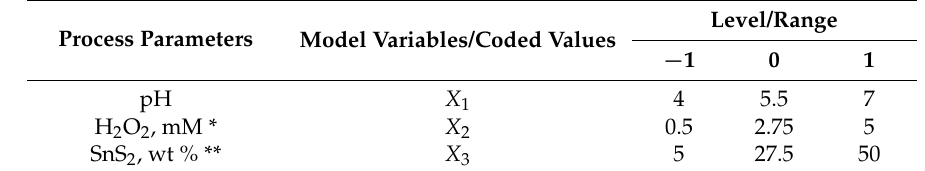
Table 1. Experimental range and levels of the independent variables for the solar driven photocatalytic treatment of DCF using immobilized TiO 2 -SnS 2 -COMM and TiO 2 -SnS 2 -HT in the presence and